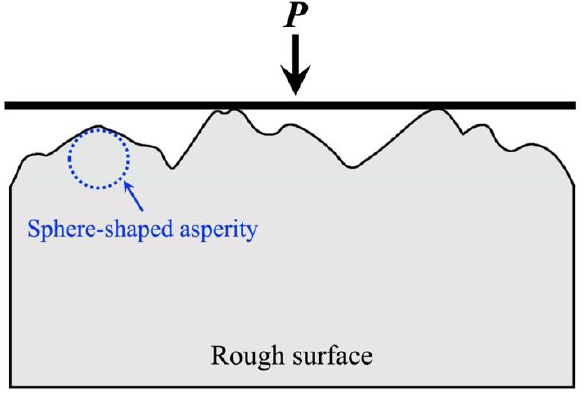
Figure 2. Contact schematic of multi-asperities rough surface: a real rough surface is in contact with a rigid smooth, which can be seen as made up of a series of spherical asperities.